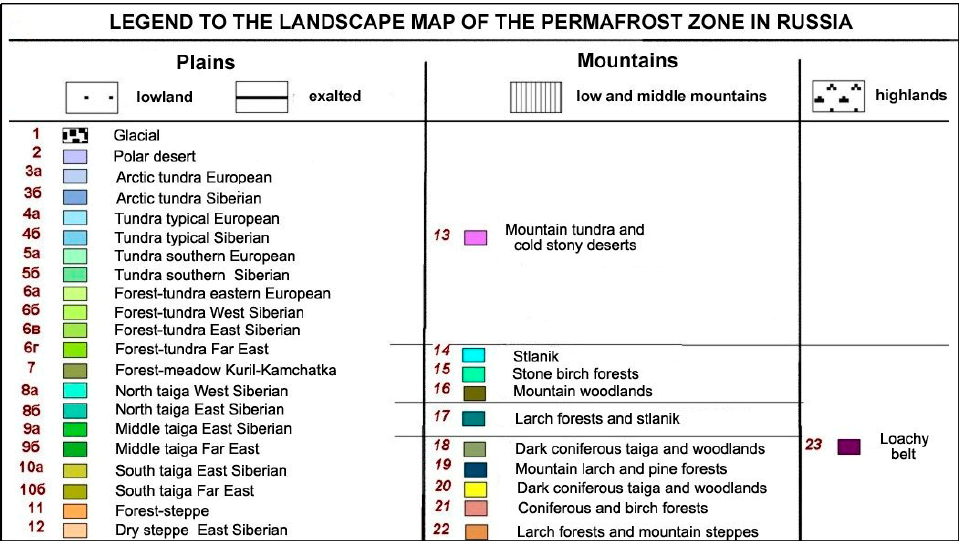
Figure 6. Legend to the landscape map of the permafrost zone in Russia.